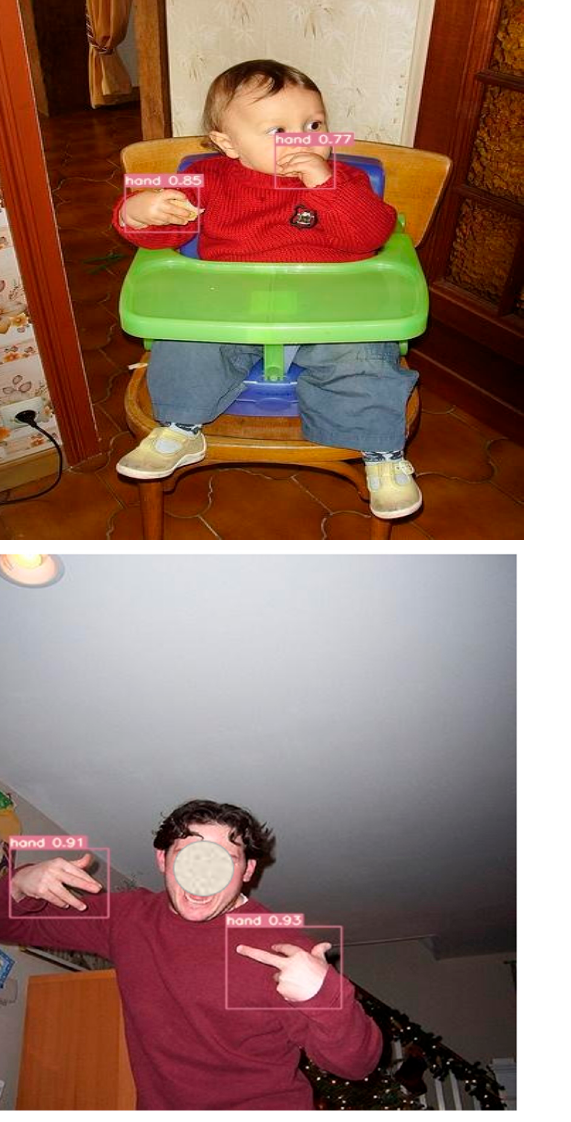
Figure 7. Recognition result of Oxford Hand Dataset with Yolov7x. Source: The human faces in the fi gures are all from public datasets (Oxford Hand Dataset).